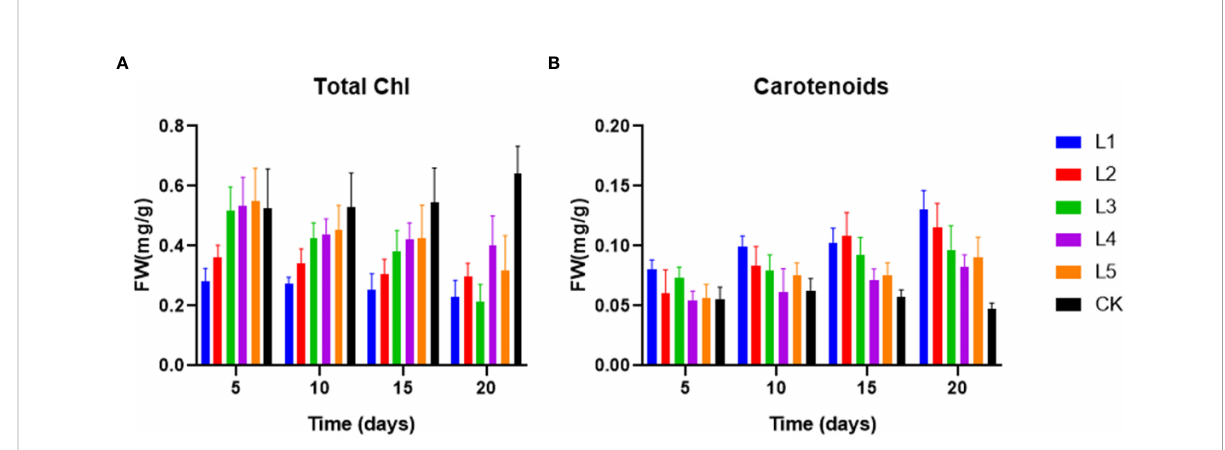
FIGURE 2 The content of photosynthetic pigments: total Chl (A) and carotenoids (B) in fronds of Lemna aequinoctialis exposed to different concentration of streptomycin in